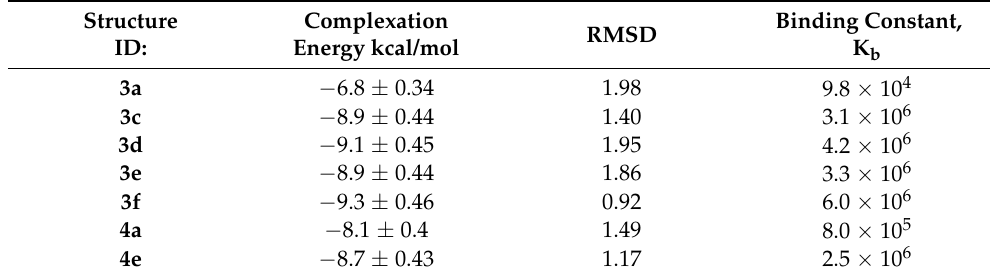
Table 9. Biophysical calculation of complexations of compounds ( 3a , 3c – f , 4a and 4e ) with 5HT_1A.